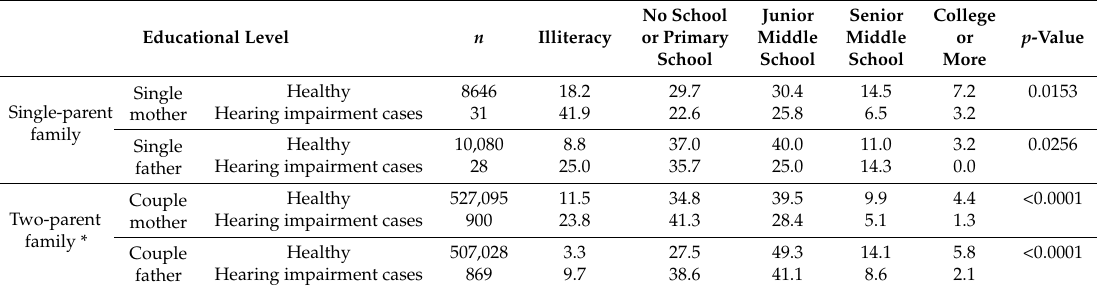
Table 6. Percentage of parental educational level by family structure